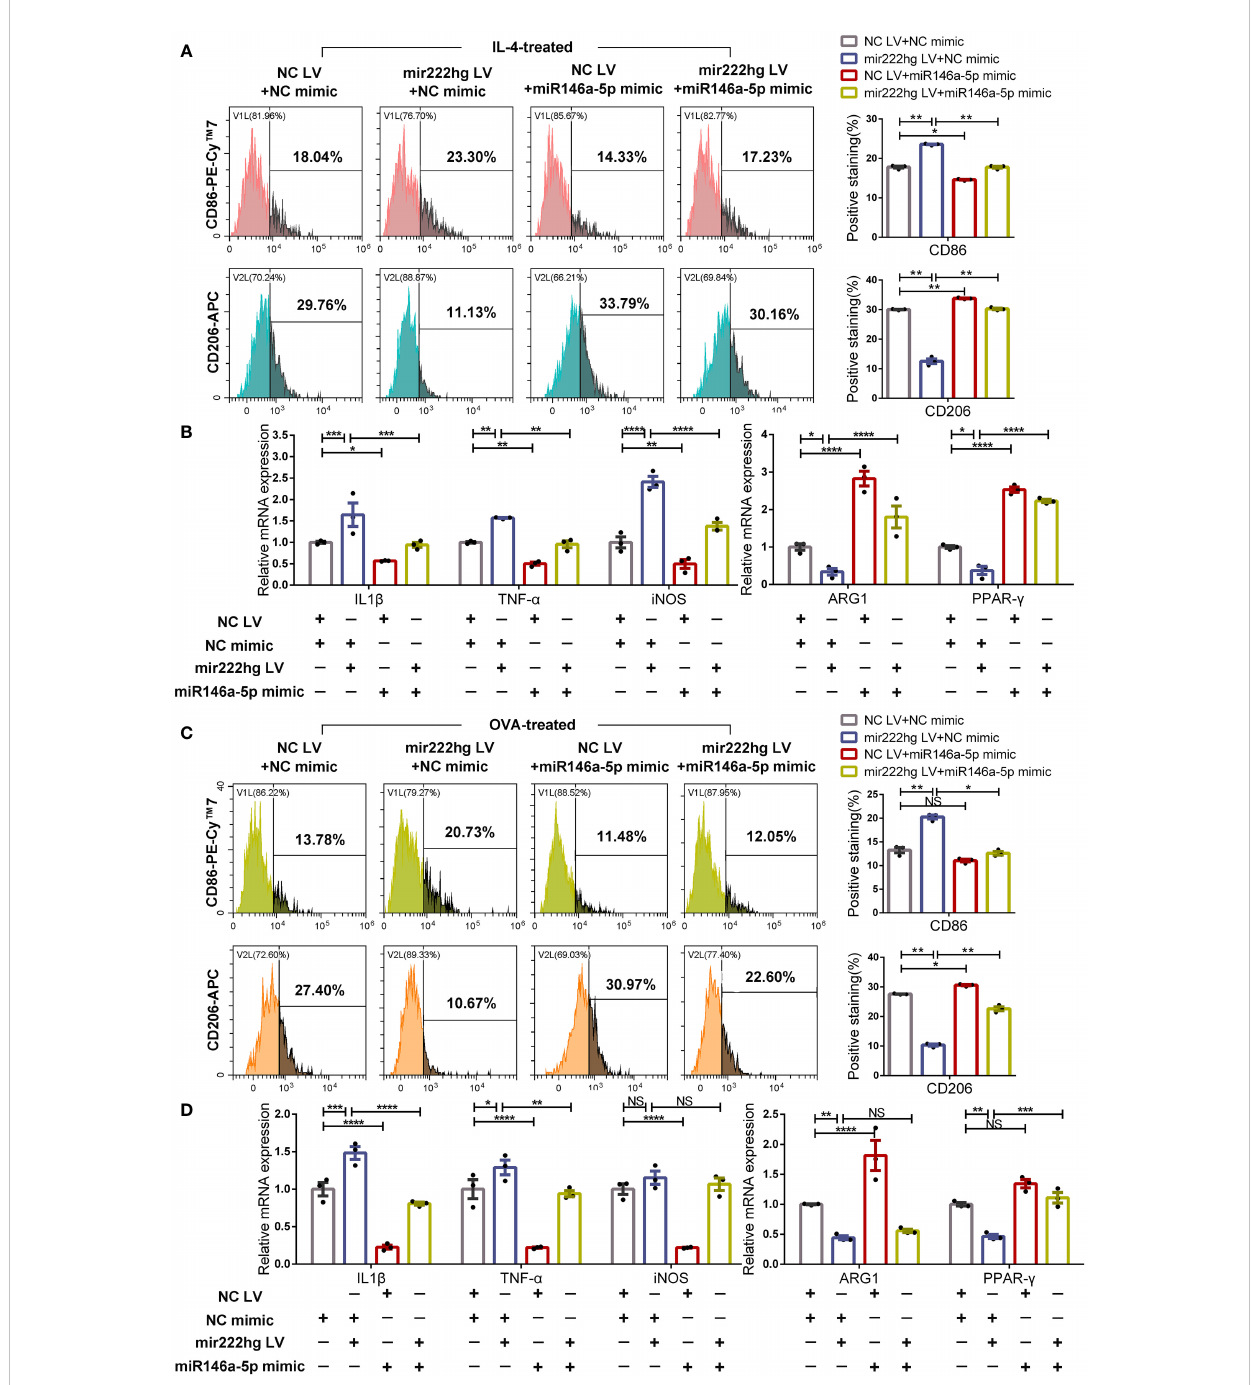
FIGURE 7 MiR146a-5p overexpression facilitates macrophage M2 polarization and reverses M1 polarization caused by mir222hg overexpression RAW264.7 cells were transfected with NC LV + NC mimic, mir222hg LV + NC mimic, NC LV + miR146a-5p mimic, or mir222hg LV + miR146a-5p mimic. (A, B) The transfected RAW264.7 cells were treated with 40 ng/ml IL-4 for 48 h. (A) Representative fl ow cytometry histograms (left) and statistical analysis (right) showing the surface expression of CD86 and CD206. (B) qRT-PCR was performed to detect IL-1 b , TNF- a , iNOS, ARG1, and PPAR- g relative mRNA expression. (C, D) The transfected RAW264.7 cells were treated with 500 m g/ml OVA for 48 h. (C) Representative fl ow cytometry histograms (left) and statistical analysis (right) showing the surface expression of CD86 and CD206. (D) qRT-PCR was conducted to detect IL-1 b , TNF- a , iNOS, ARG1, and PPAR- g relative mRNA expression. Each point represents data from one individual sample. Data are shown as the mean ± SEMs (n= 3 per group). Data are merged from three independent experiments. Statistical signi fi cance was calculated by two-way ANOVA followed by Sidak ’ s multiple comparisons test. * p< 0.05, ** p< 0.01, *** p< 0.001, **** p< 0.0001, NS no signi fi